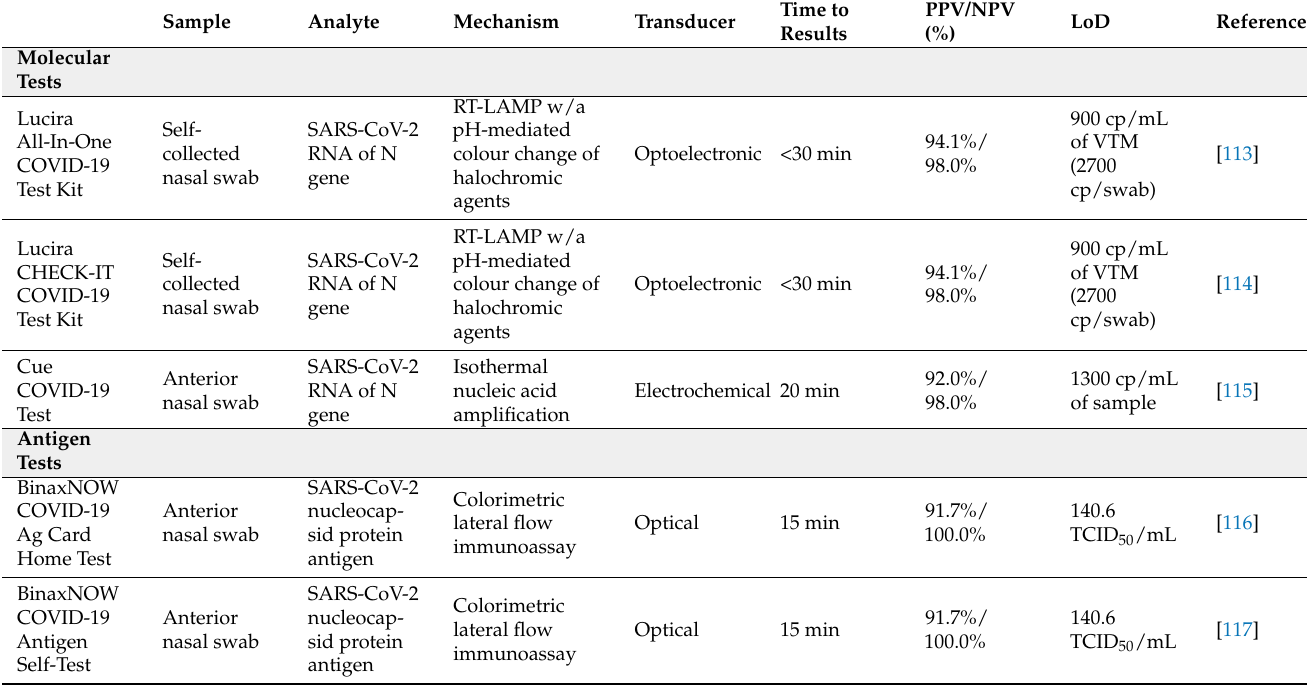
Table 4. EUA-granted tests for at-home